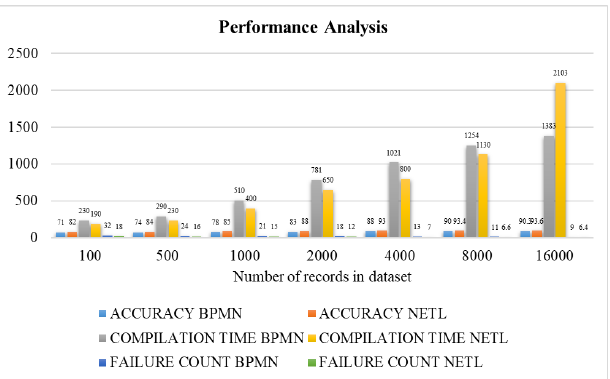
Figure 9. Performance